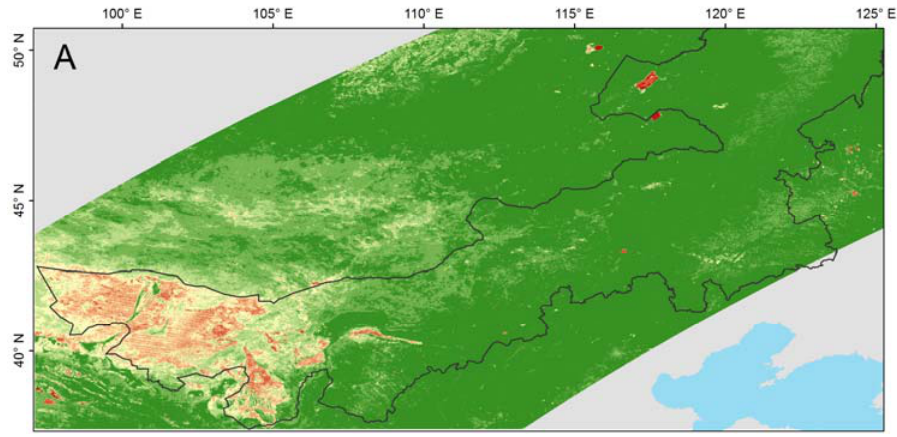
Figure 2. Pearson’s correlation coefficient ( r value) between monthly 1-km Système Probatoire d’Observation de la Terre VEGETATION (SPOT VGT) and Moderate-Resolution Imaging Spectroradiometer (MODIS) ( A ), monthly 8-km SPOT VGT and Advanced Very High Resolution Radiometer Global Inventory Modeling and Mapping Studies (AVHRR GIMMS) ( B